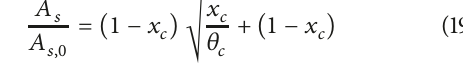
partial pressure of 1 atm [31], specifically 305 g/cm 2 s(atm)